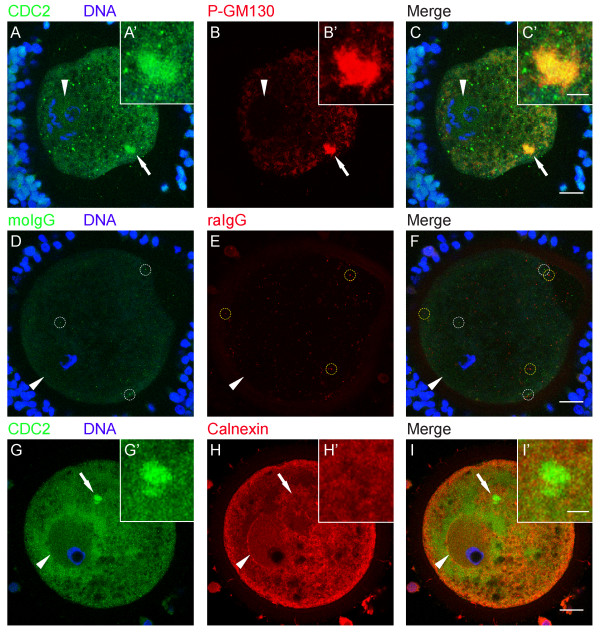
The fragmented Golgi marker P-GM130 colocalizes with CDC2 at ERES in immature oocytes. (A-C) 0 h GV stage oocyte labeled for CDC2 (A, green), DNA (A, blue), and phosphorylated GM130 (B, red). Colocalization (yellow) of CDC2 and phosphorylated GM130 in a cortical compartment in the ooplasm is evident in the merged image (C). (D-F) 0 h GV stage oocyte from the same experiment as A-C, labeled with moIgG (D, green), DNA-marker (D, blue), and rabbit IgG (raIgG, E, red). None of the aspecific dots (examples are marked with white circles in D, F and yellow circles in E, F) colocalize in the merged image (F). This control image was subjected to the same enhancements as A-C, and selected to show confocal sections from an equivalent acquisition depth. (G-I) 0 h GV stage oocyte labeled for CDC2 (G, green), DNA (G, blue), and the ER-marker calnexin (H, red). No colocalization (yellow) of CDC2 and calnexin was observed in the merged image (I). Images are Z-projections of 6 consecutive sections (A-F), or 3 consecutive sections (G-I); scale bars represent 20 μm in C, F, and I, and 5 μm in C' and I'. Arrows indicate the region of the oocyte that is shown enlarged in the insets (A'-C' and G'-I'). Arrowheads denote the position of the GV.